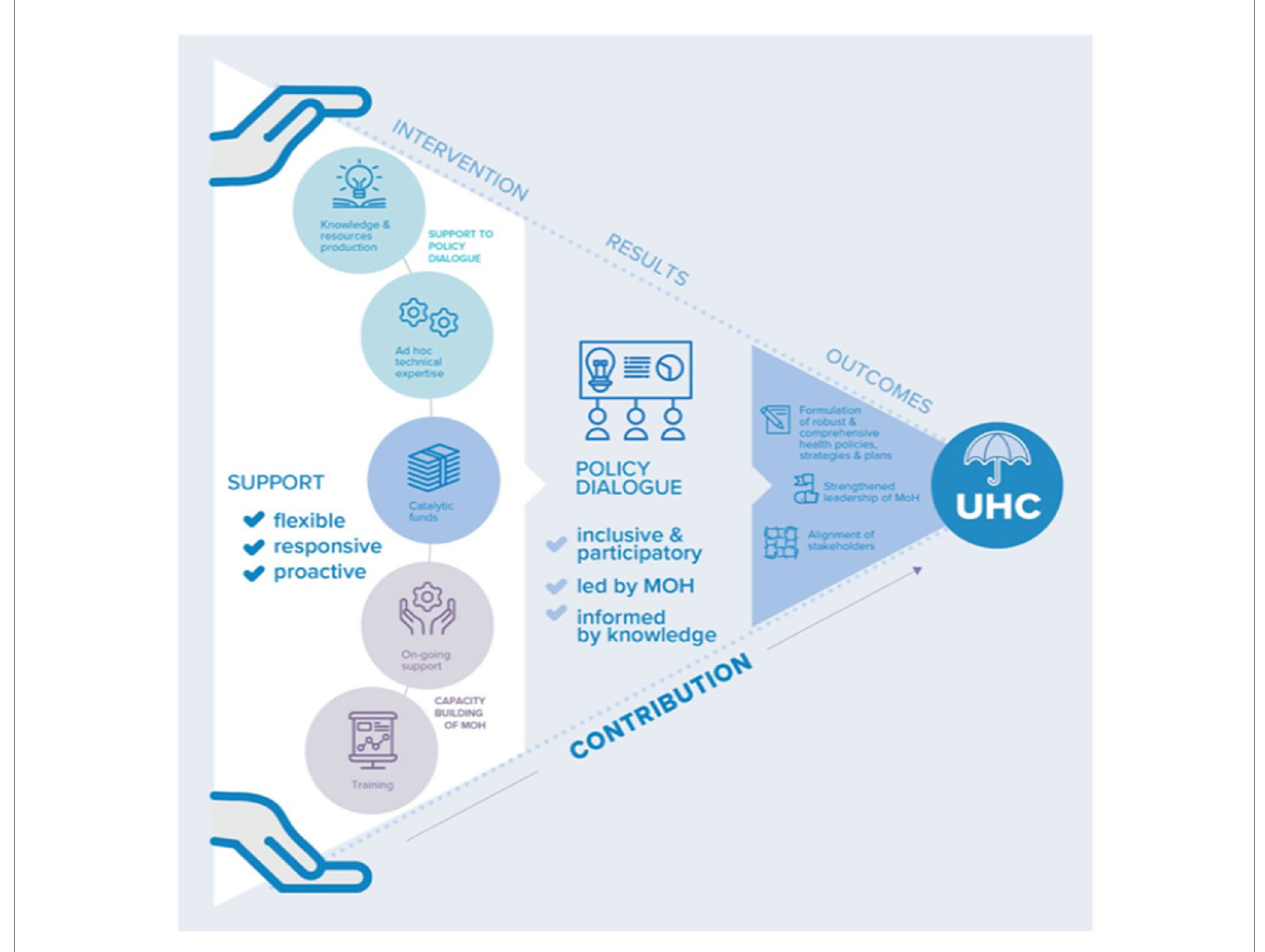
FIGURE 2 UHC Partnership theory highlighted by the realist